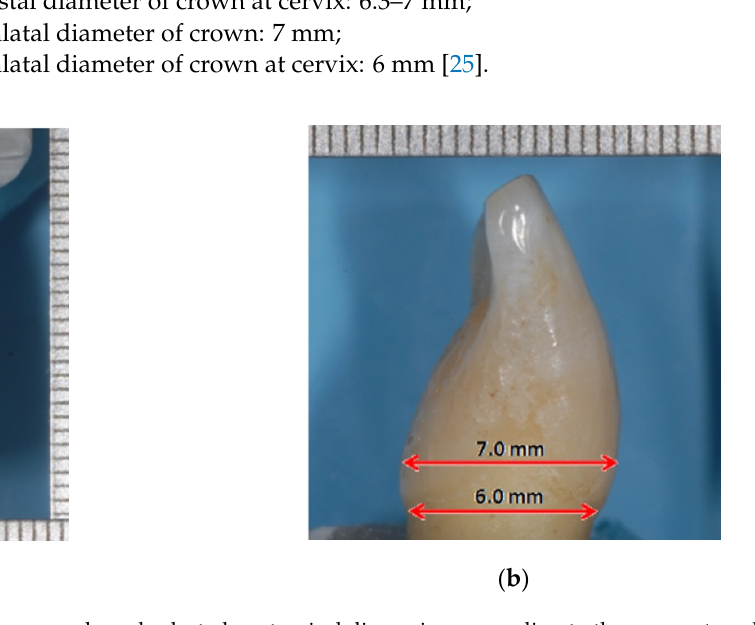
Figure 2. Reference scale and selected anatomical dimensions according to the parameters described by Nelson and Ash. ( a ) crown length and mesiodistal diameters; ( b ) buccopalatal diameters. Each dash is spaced half a millimeter apart.